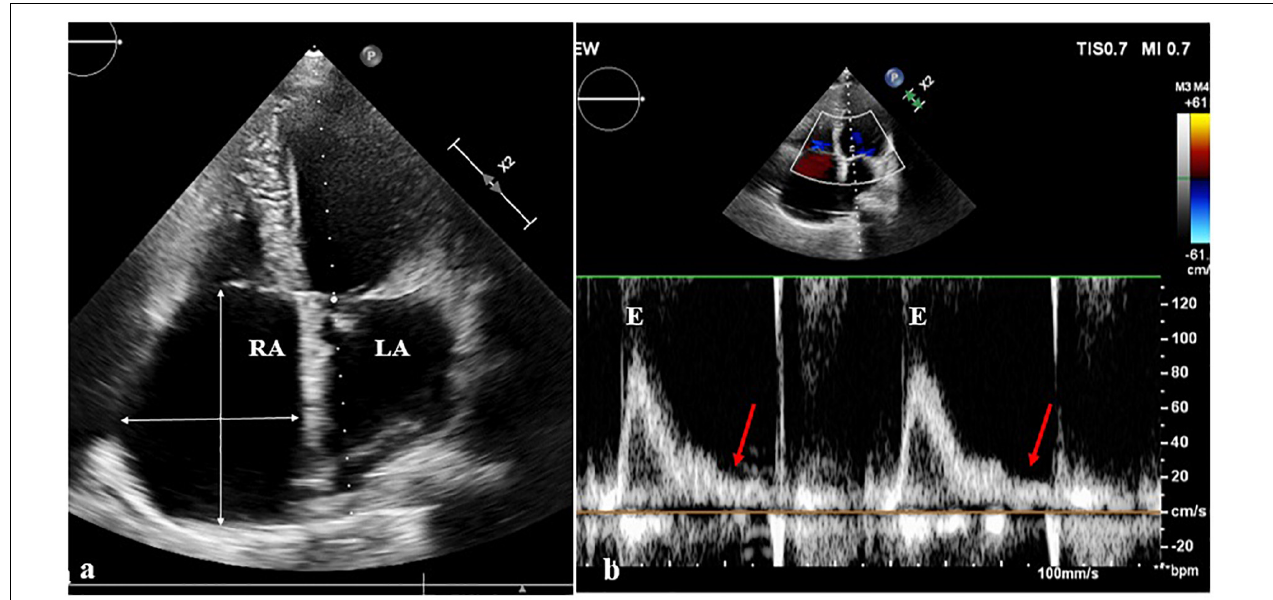
FIGURE 1 | Echocardiography images. (a) On the echocardiography, both atrium were observably enlarged, the right atrium (RA) size was 8.9 cm × 5.6 cm, and the left atrium (LA) size was 7.2 cm × 5.6 cm. (b) In the mitral inflow pulse by Doppler recording, only E wave was observed in the early diastolic period, but no A wave was observed in the late diastolic